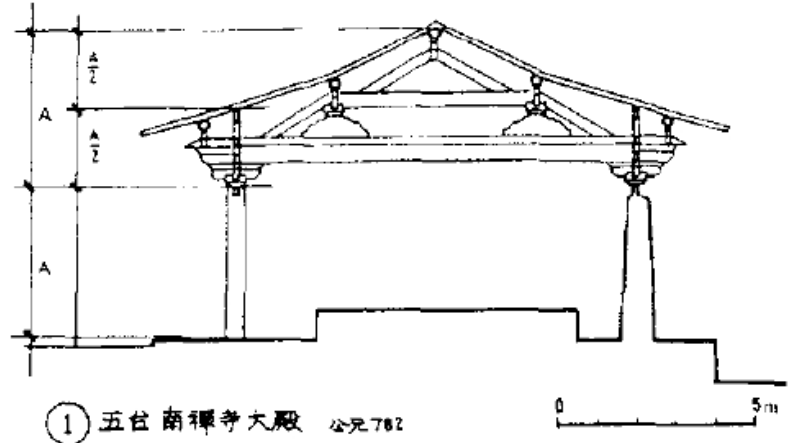
Figure 3. The main hall of Nanchansi Monastery and Fu Xinian’s proportional interpretation, Adapted from Fu (2001, p.108).